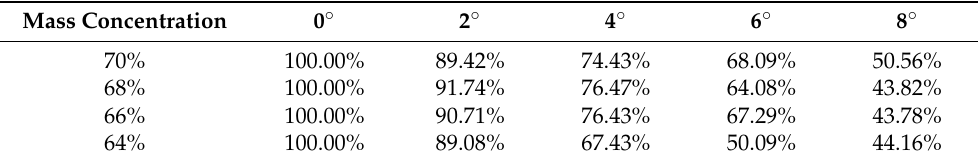
Table 6. Reduction coefficient of uniaxial compressive strength of inclined slicing backfill.